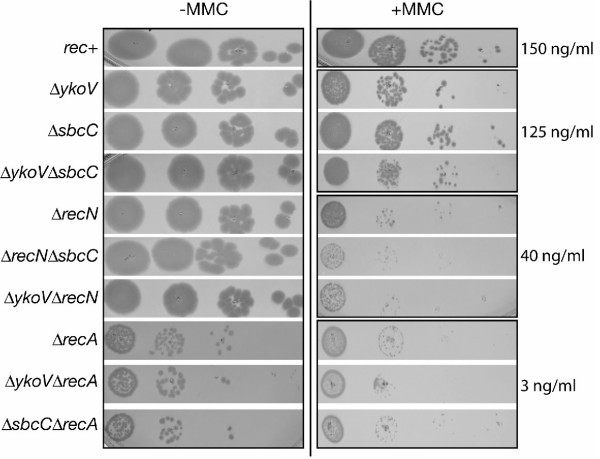
DNA repair sensitivity of exponential-phase ΔsbcC and ΔykoV mutants to the killing action of MMC. The strains used are indicated by the relevant genotype. Serial dilutions of a culture of each strain were plated in selective medium containing the indicated concentration of MMC. Wild type cells were exposed to 150 ng/ml, ΔsbcC, ΔykoV or ΔsbcC ΔykoV to 125 ng/ml, ΔrecN, ΔsbcC ΔrecN or ΔykoV ΔrecN to 40 ng/ml and ΔrecA, ΔykoV ΔrecA or ΔsbcC ΔrecA were exposed to 3 ng/ml of MMC. At least three independent experiments were performed and one of them is presented.